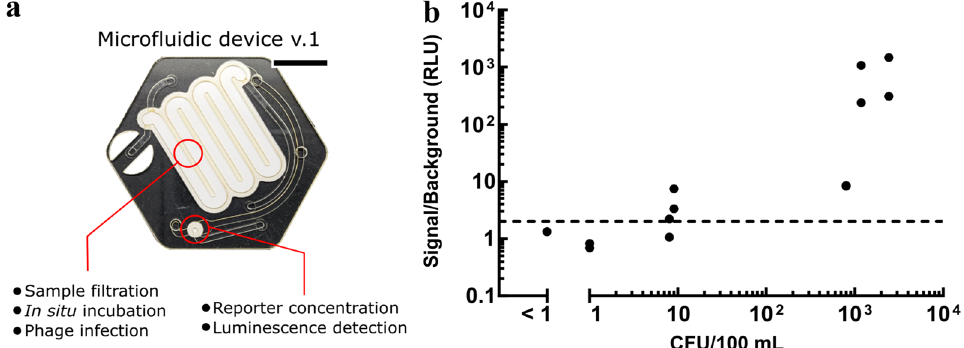
Figure 4. Validation of preliminary phage cocktail assay on local sewage samples. ( a ) First prototype of the microfluidic device for the detection of E. coli in water samples. Scale bar: 10 mm ( b ) Luminescence signal normalized to phage only background of water samples obtained using a cocktail of 4 phages (Phi3, Phi7, RB69, and T7) and processed through the microfluidic chip device. Water samples were collected from the Ngong river flowing through the city of Nairobi. CFU values were determined using a membrane filtration field kit. The dashed line represents values at 2×